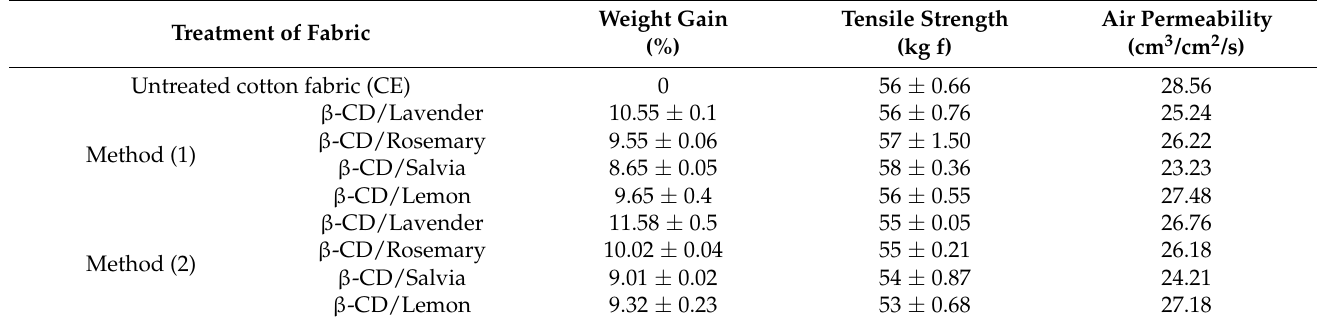
Table 3. Weight gain, tensile strength, and air permeability measurements of cotton fabric treated with inclusion complexes via methods 1 and